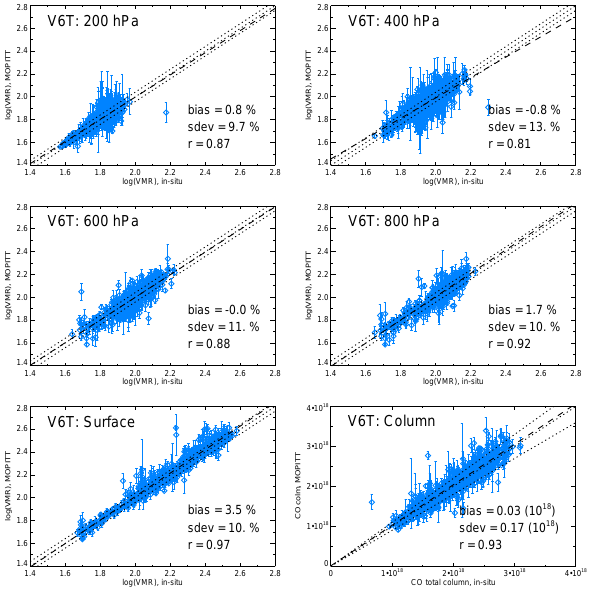
Figure 5. Scatterplots showing V6 TIR/NIR (V6J) validation results based on NOAA profiles. See caption to Fig.